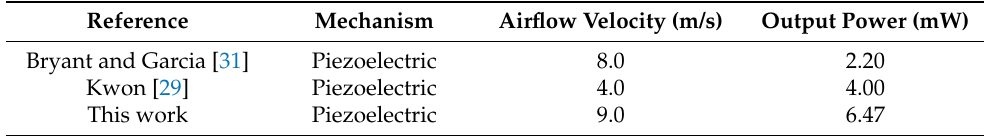
Table 7. Comparison of the proposed and existing energy